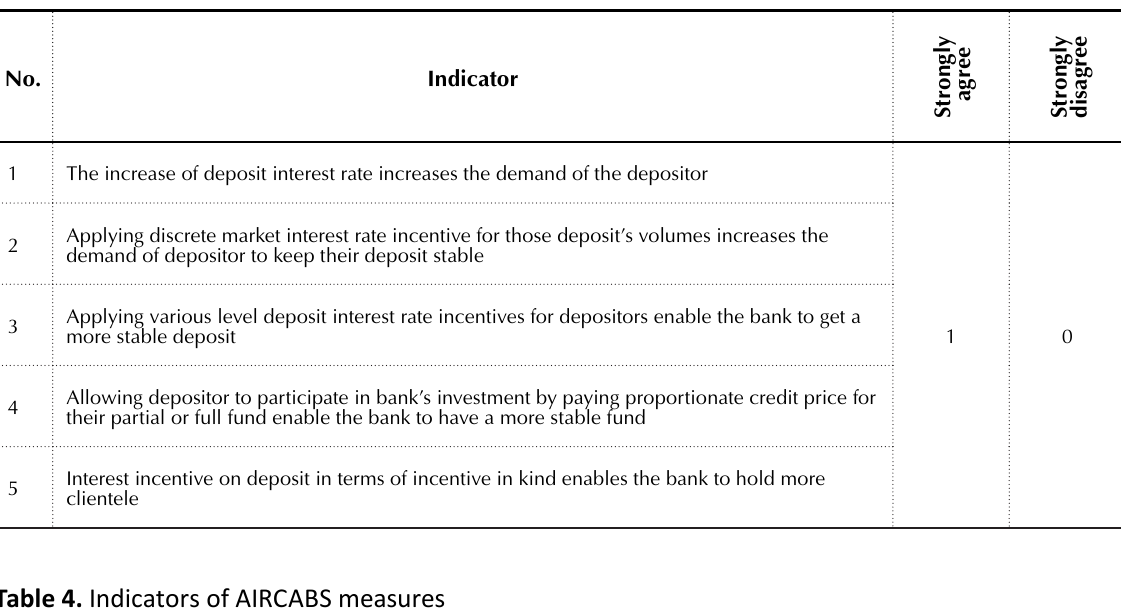
Table 3. Indicators of discrete market deposit interest incentive measures